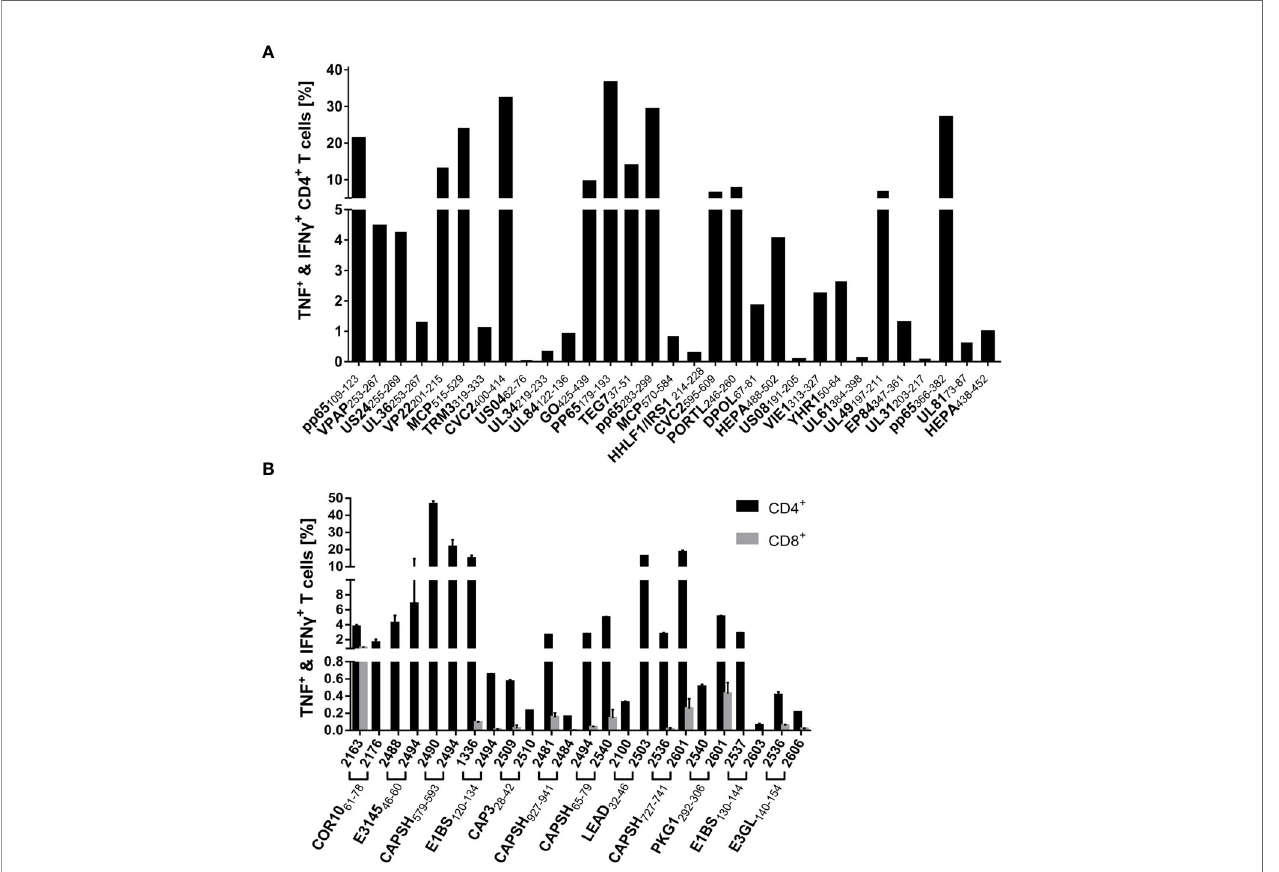
FIGURE 5 | ICS characterization of virus-speci fi c T cells. Dominant epitopes identi fi ed in ELISpot assays were validated in ICS after a 12-day stimulation with peptide and IL-2. IFN g and TNF responses were evaluated as positive if threefold higher than in the negative control and ≥ 0,1% (A) Percentage of cytokine-positive CD4 + T cells of one representative PBMC culture per HCMV epitope. (B) Mean percentage of IFN g + TNF + CD4 + (black) and CD8 + (grey) T cells for all tested PBMC cultures (n = 2 per HAdV